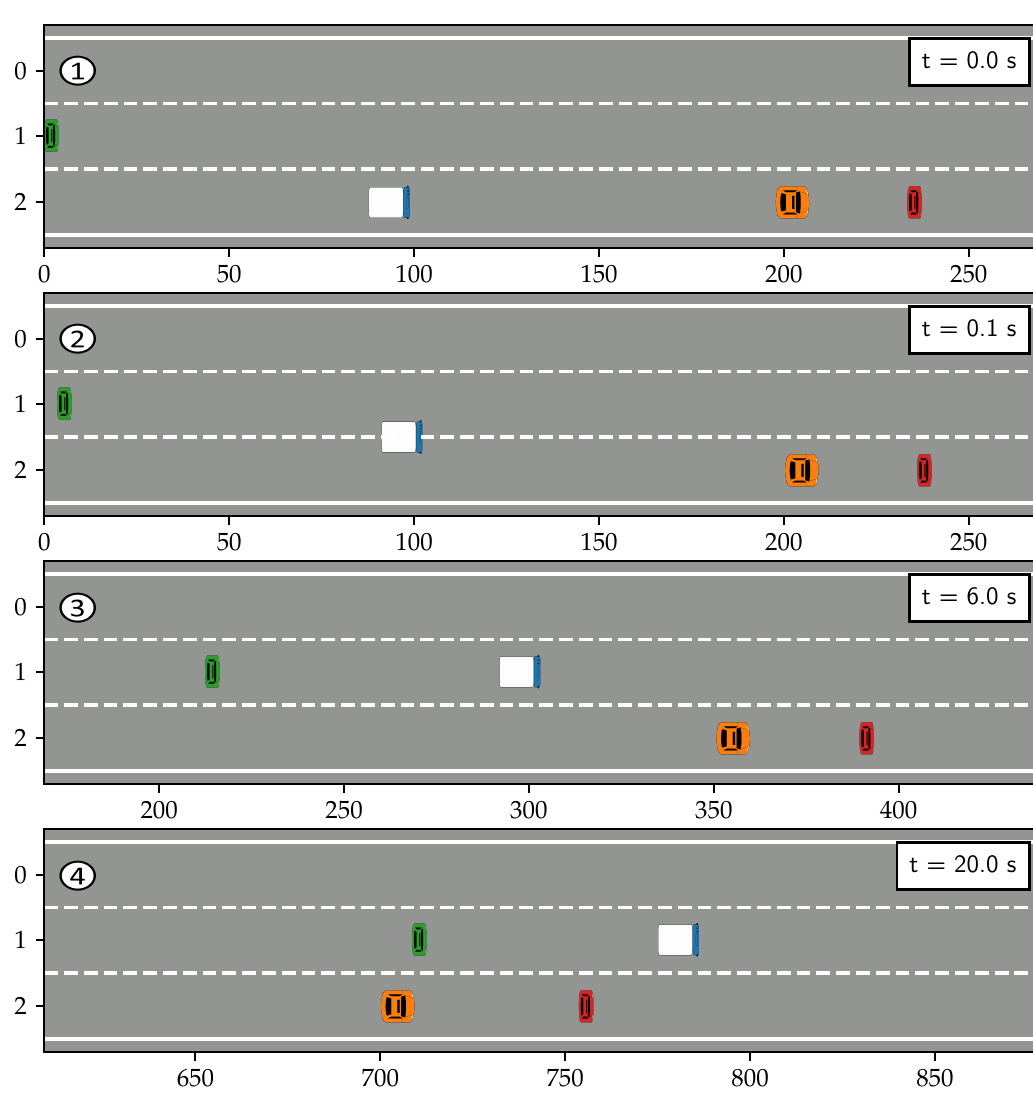
Figure 5. Lateral plot of the global